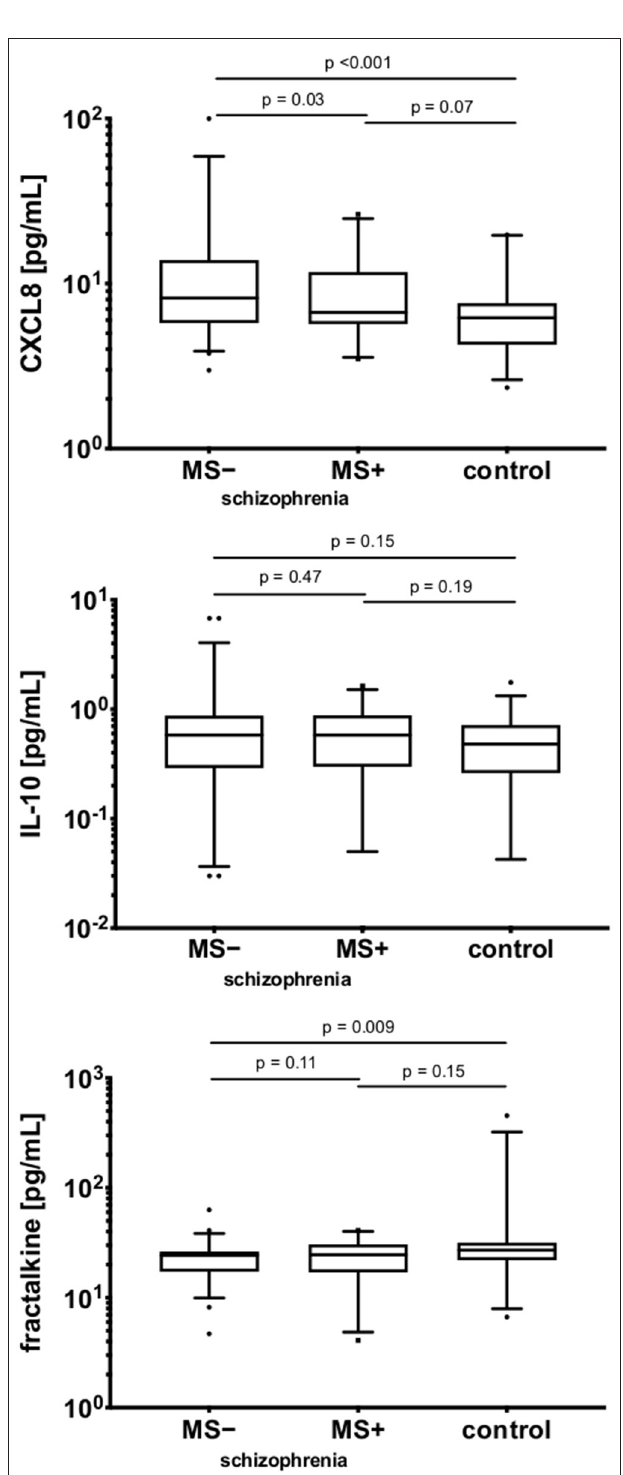
FIGURE 3 | The comparison of serum CXCL8, IL-10, and fractalkine in the schizophrenia and control groups.MS − , patients on mood-stabilizers; MS + , patients without stabilizers. Y axes are log10 scaled. The boxes extend from 25 to 75th percentiles, the lines in the middle of the boxes represent medians. The whiskers extend from 10 to 90th